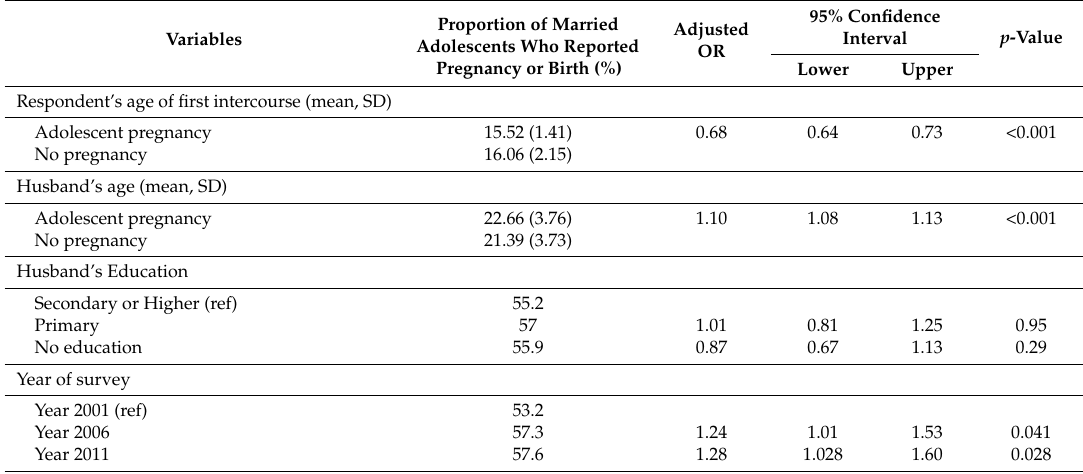
Table 4. Logistic regression of factors associated with pregnancy among married adolescent women. Variables